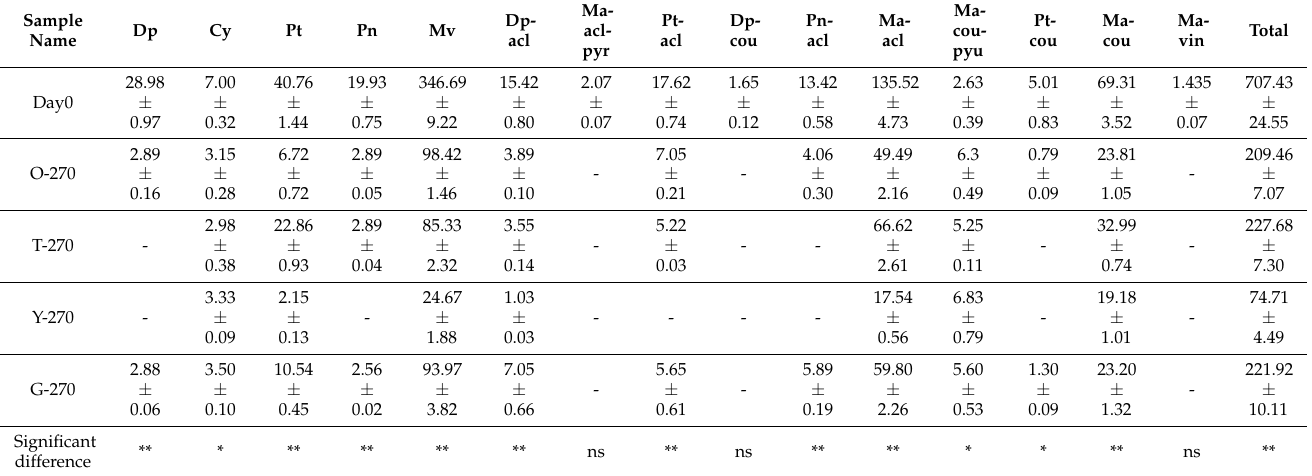
The abbreviations and full names of the compounds in Table 4 are as follows: Delphinidin3-O-glucoside (Dp), Cyanidin3-O-glucoside (Cy), Petunidin3-O-glucoside (Pt), Peonidin3-O-glucoside (Pn),